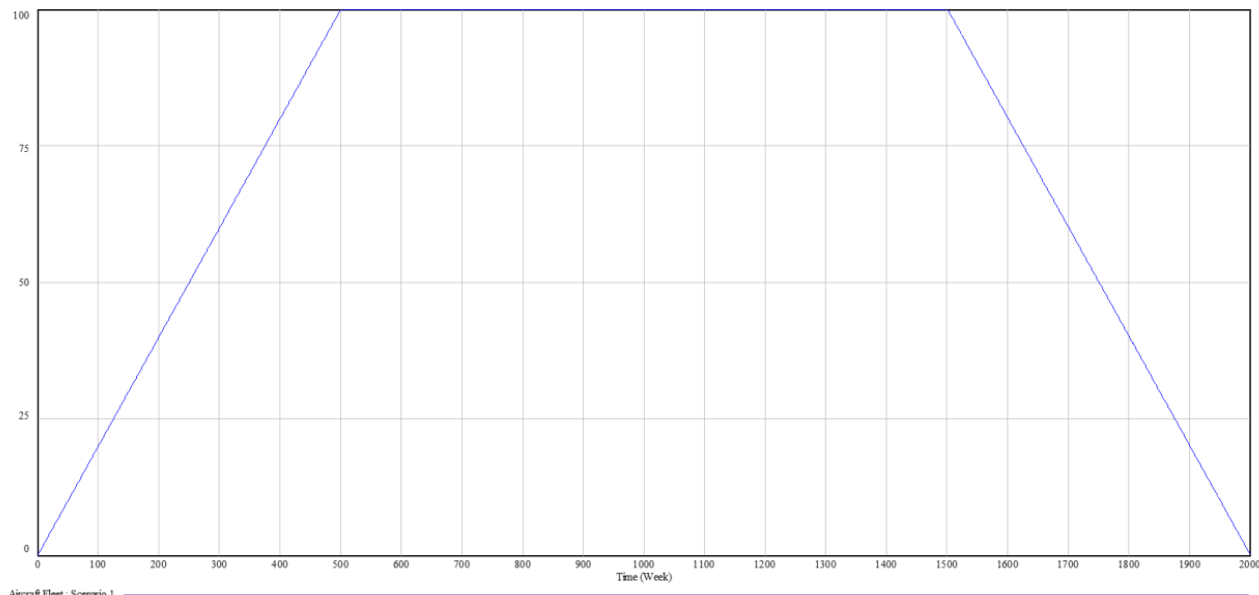
Figure 7. Aircraft fleet over the simulation timeframe (own elaboration).